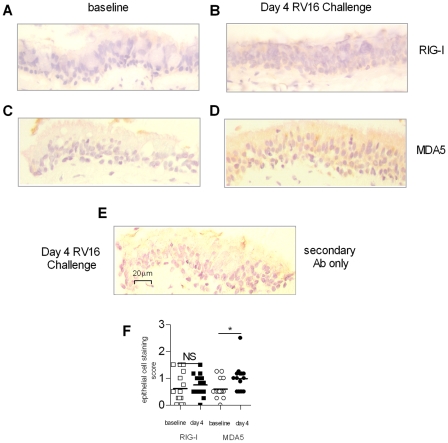
RIG-I and MDA5 expression in bronchial biopsy tissue following in vivo RV16 infection.Normal individuals underwent fibre-optic bronchoscopy at baseline or day 4 following RV16 challenge, and bronchial biopsies were taken, and assessed for RIG-I protein by immunohistochemistry at baseline (A) and day 4 post RV16 challenge (B). Biopsies were also assessed for MDA5 protein at baseline (C) and day 4 post RV16 challenge (D). Positive staining is indicated by the brown coloration, localized to the columnar epithelial cells. Background staining was assessed by incubating a Day 4 biopsy with secondary antibody only (E). Staining scores of bronchial epithelium showing increases at day 4 compared to baseline (F) *p<0.05 as indicated, NS  =  not significant. Scale is indicated by the horizontal bar.